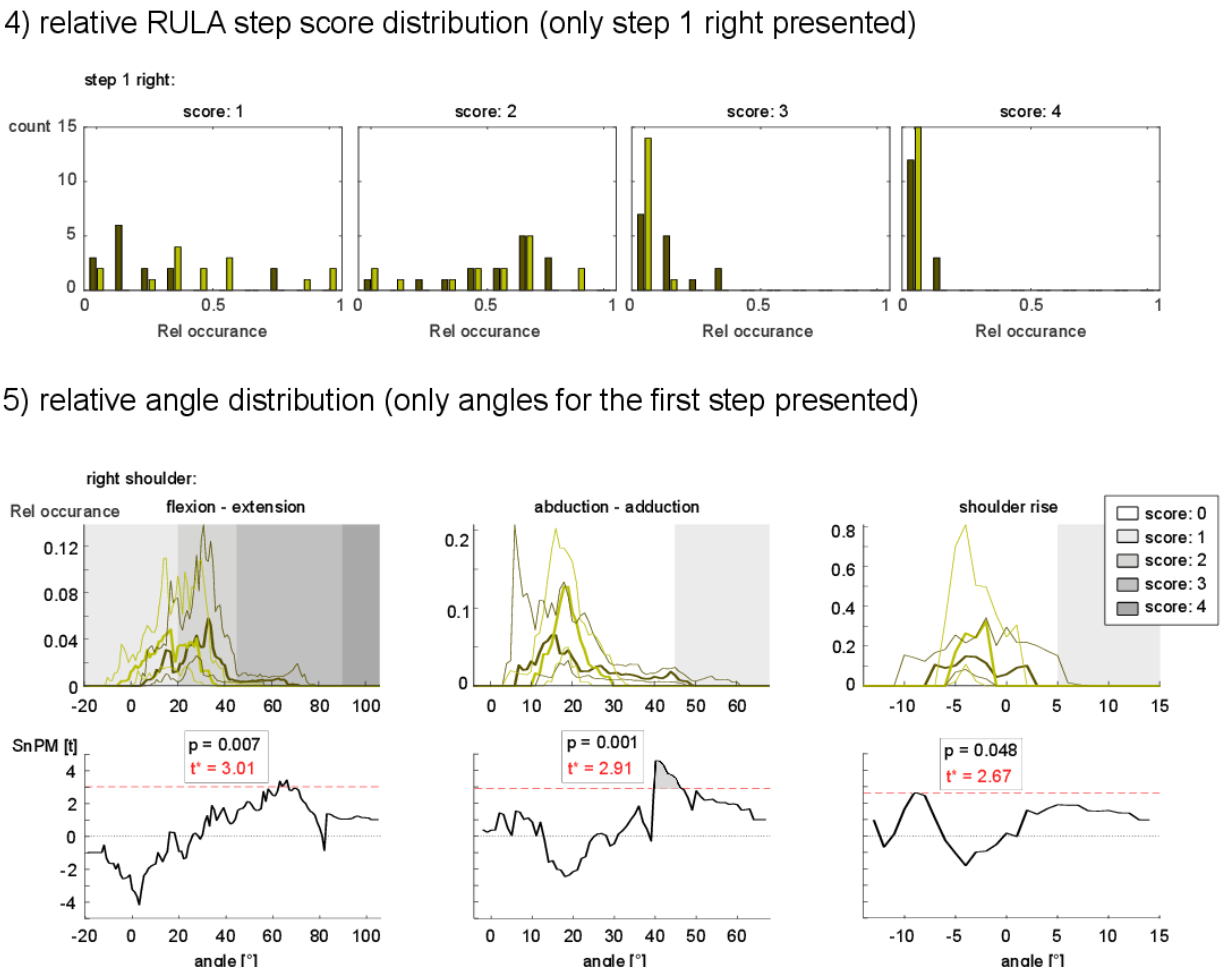
Figure 5. Levels of complexity. The plots show the different metrics calculated from the IMU-based RULA assessment. From top to bottom, the graphs increase the complexity. The RULA score has only one value per condition. C1 indicates treatment concept 1, and C2 indicates treatment concept